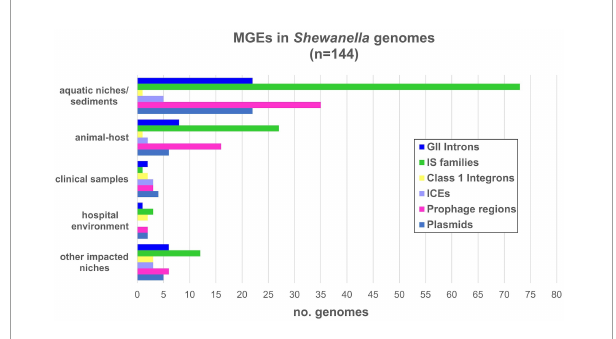
FIGURE2 Mobile genetic elements detected in Shewanella spp. from different niches. Number of MGE types detected in each genome: GII introns (group II introns); IS families (insertion sequence families) listed in Supplementary Table 10 ; IntI: mobile class 1 integrons; ICE (integrative and conjugative elements); prophage regions with intact and questionable scores listed in Supplementary Table 11 ; plasmids listed in Supplementary Table 9